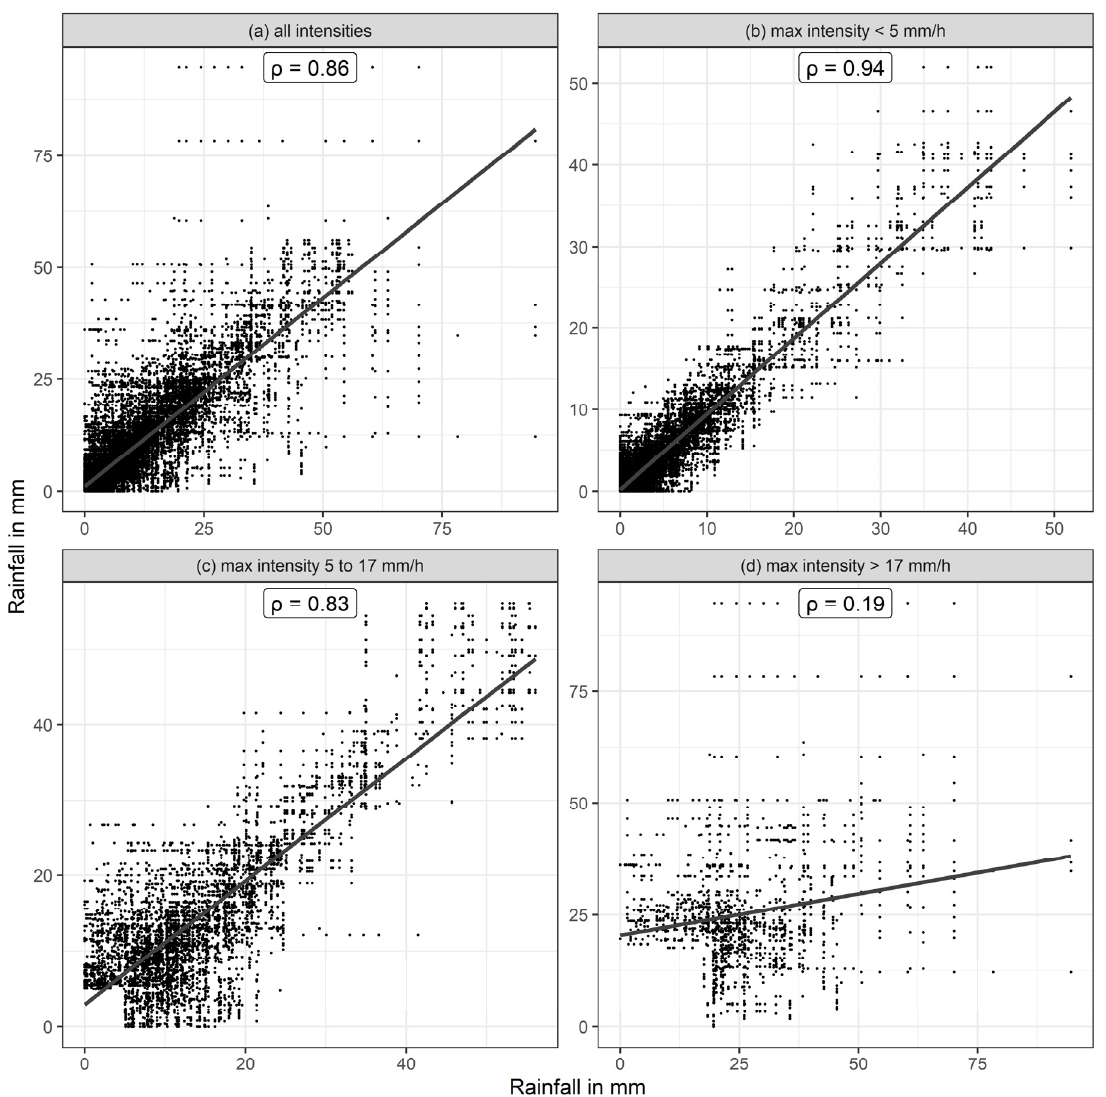
Figure 2. Rain gauge to rain gauge sum comparison plots of event rainfalls in mm with the calculated Pearson coefficient ( ρ ) and the linear regression in each subplot: ( a ) all intensities together in one plot; ( b ) small intensities <5 mm/h; ( c ) medium intensities between 5 and 17 mm/h; and ( d ) high intensity storms >17 mm/h.